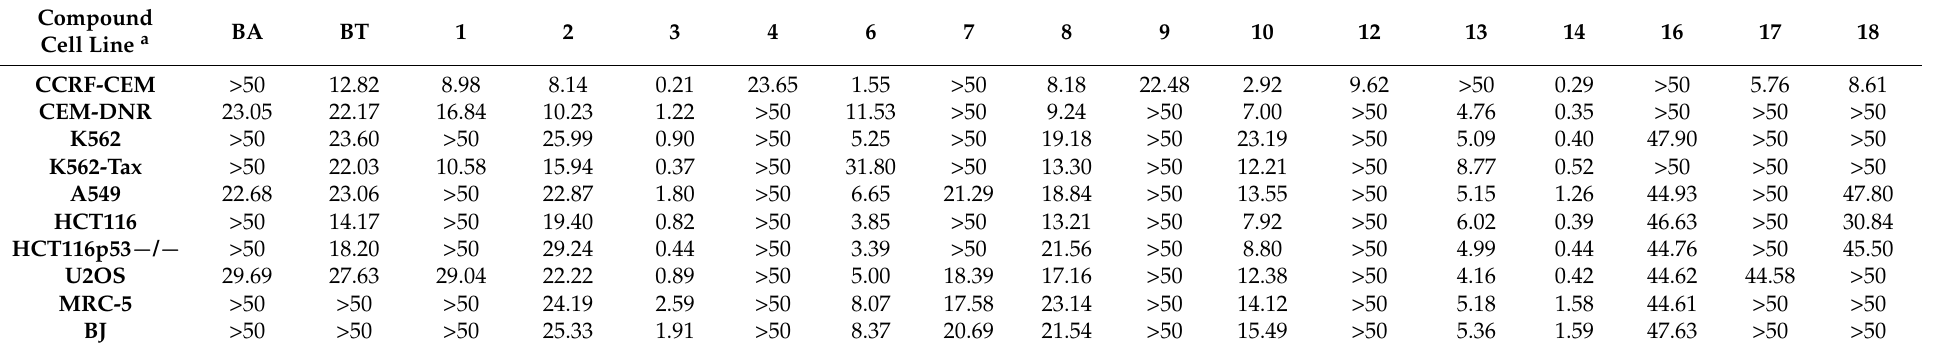
Table 1. Summary of cytotoxic activities (IC 50 , µ